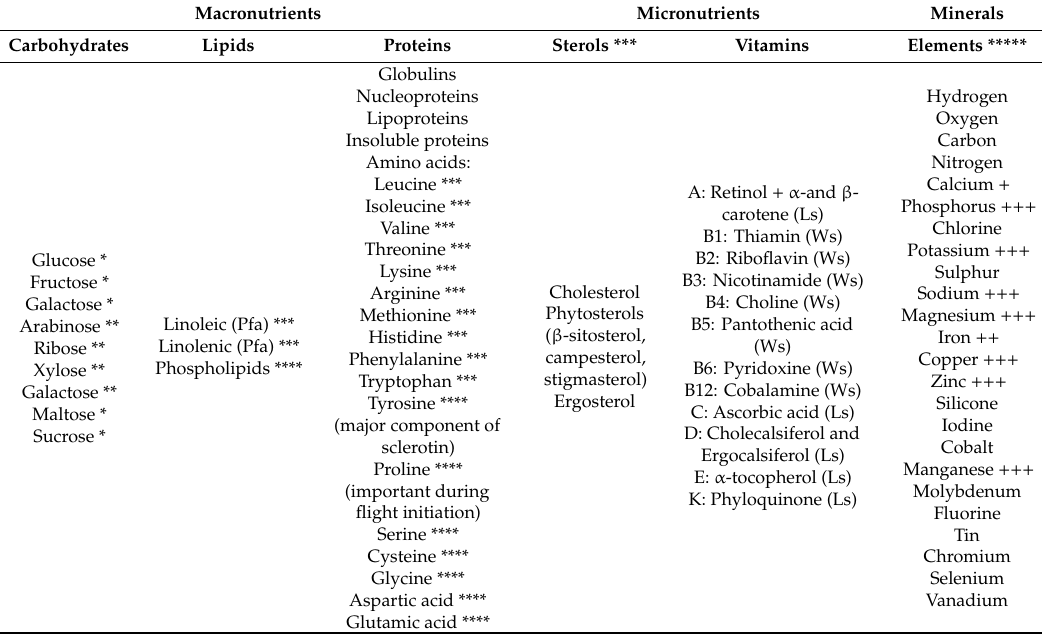
Table 3. Summary of the nutrient requirements of edible insects (adapted from [30,60]).